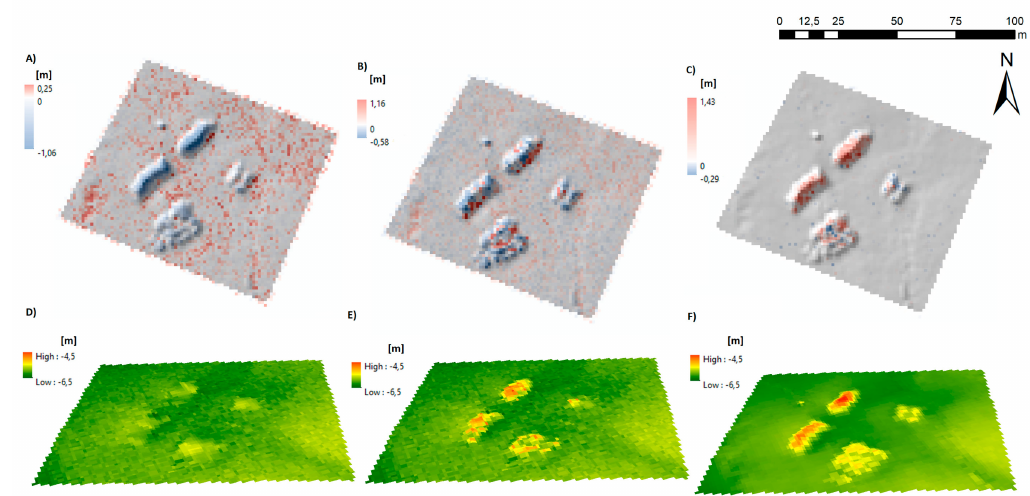
Figure 8. Visual effect of detecting new points using Gaussian decomposition in secondary analysis of Airborne Laser Bathymetry (ALB) data: hillshade models of seabed overlaid with difference of preliminary results in reference to sonar data ( A ), improved results in reference to sonar data ( B ) difference between secondary and preliminary results; ( C ) 3D visualization of seabed elevation model for preliminary results ( D ), improved results ( E ) and reference sonar data ( F ).